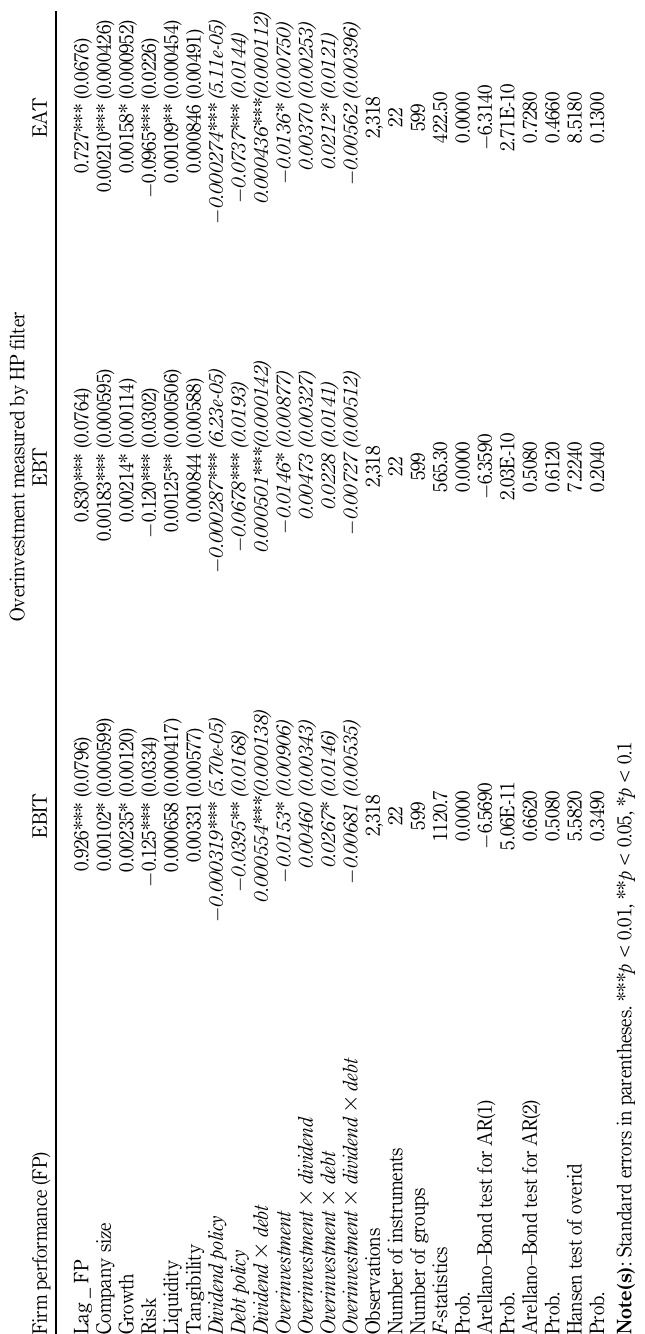
Table A3. Estimated results using HP-filter technique to measure